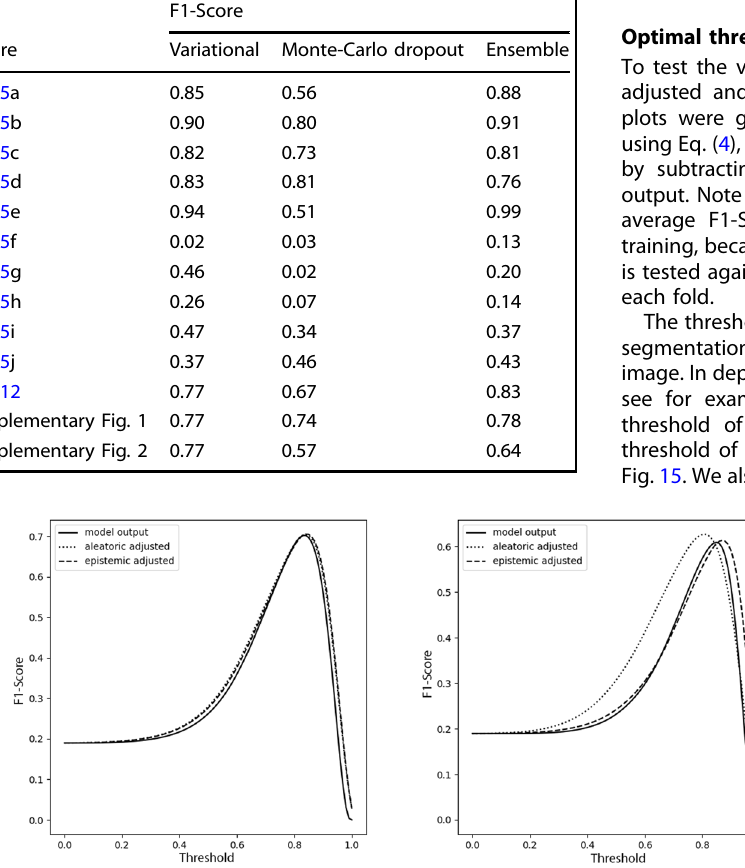
Fig. 13 F1-Score vs. Threshold plots for the training dataset. Left: variational; middle: Monte-Carlo dropout; right: ensemble.